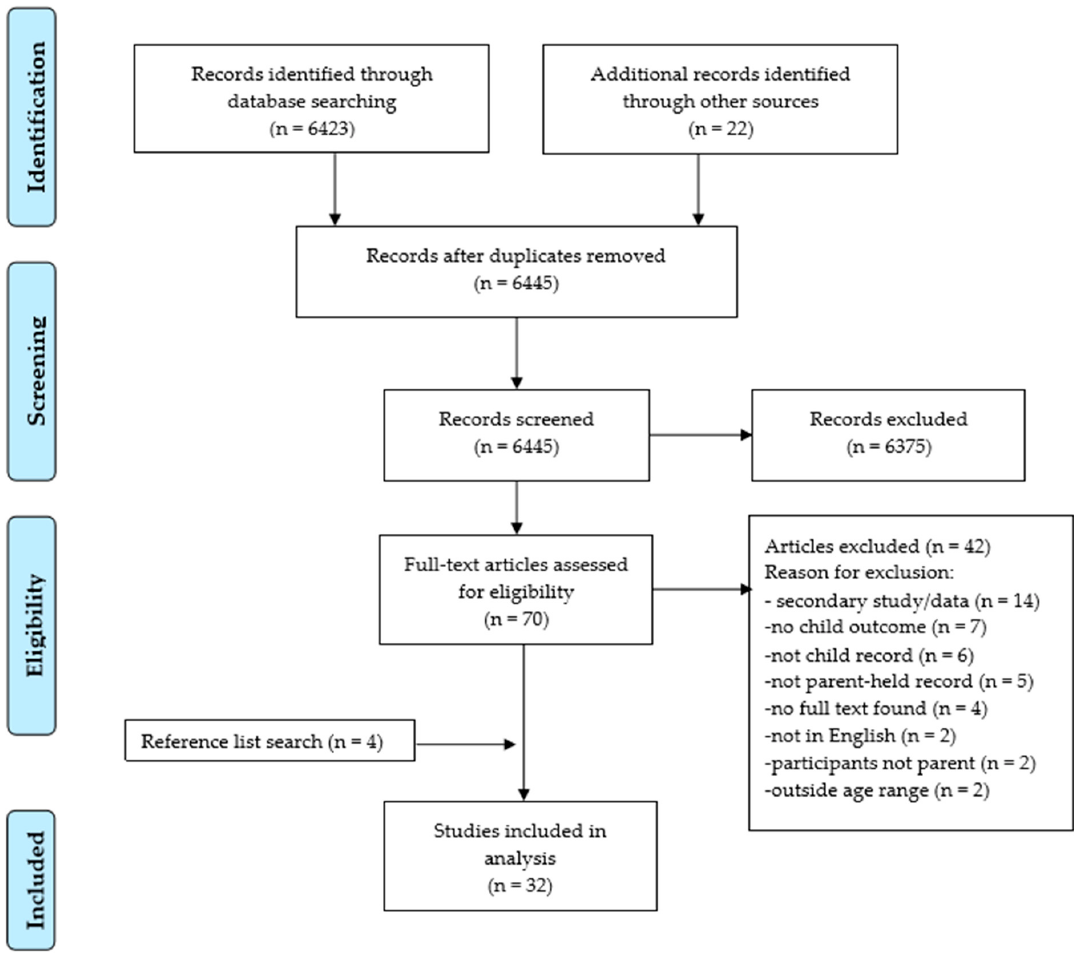
Figure 1. PRISMA (Preferred Reporting Items for Systematic Reviews and Meta Analyses) Flow chart Figure 1. PRISMA Flow chart for study selection. for study